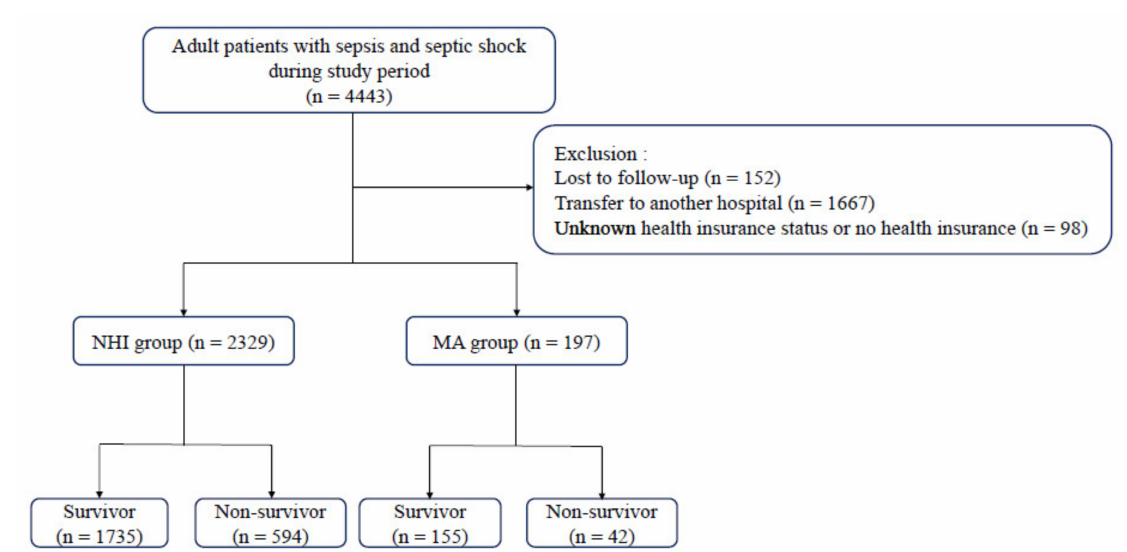
Figure 1. Flow chart of the study population. NHI, National Health Insurance; MA, Medical